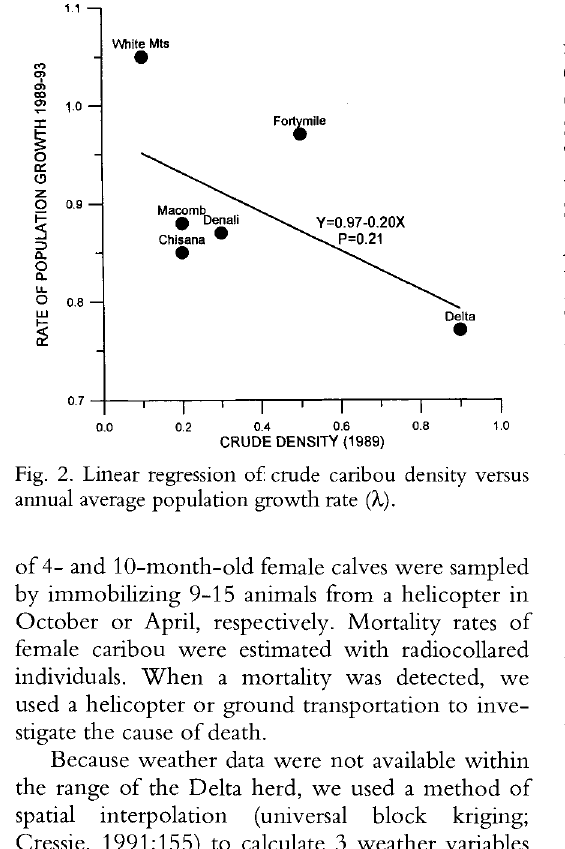
Fig. 2. Linear regression of crude caribou density versus annual average population growth rate (k).